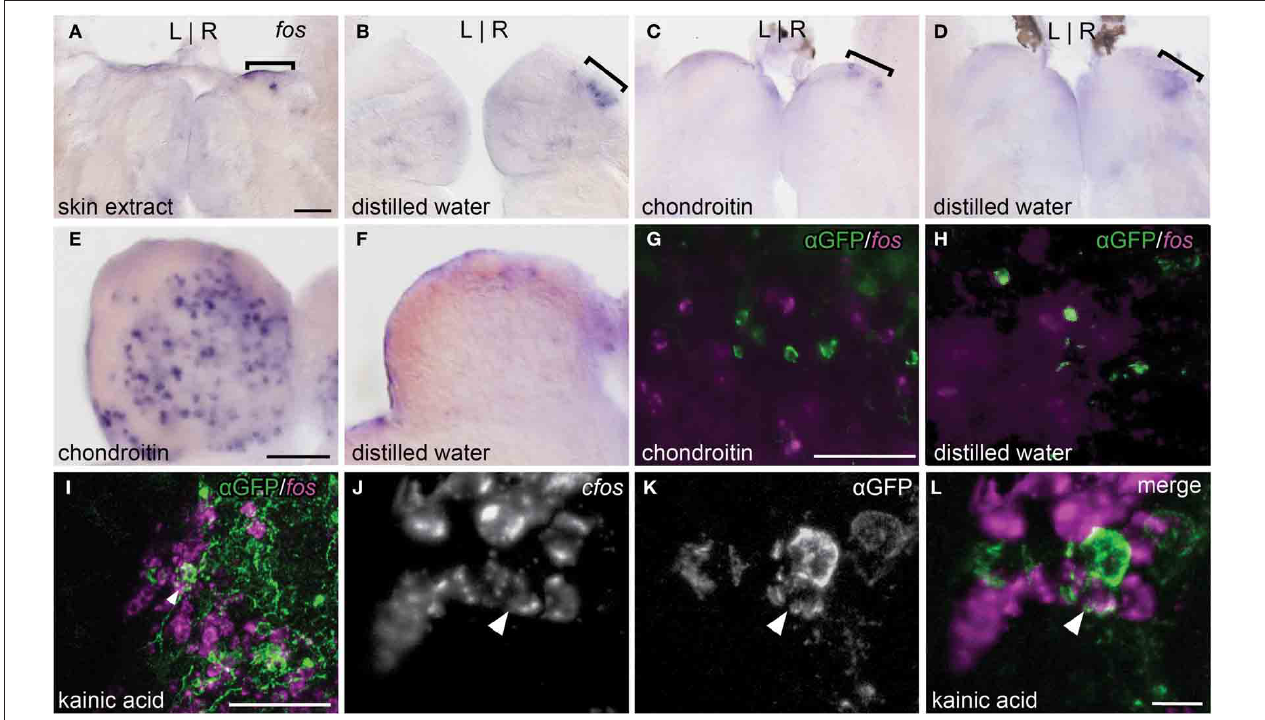
revealed by fluorescent in situ hybridization do not colocalize with immunolabeled lhx2a:YFP neurons in the olfactory bulb. (I) Kainic acid induces fos expression in a subset of lhx2a:YFP labeled olfactory neurons. (J–L) Higher magnification of (I) , with double labeled neuron indicated (white arrowhead). Coronal sections (50 μ m) of adult brains. Scale bars = 40 μ m for (A–D) , (E,F) , (G,H), and (J–L) , and 10 μ m for (I)